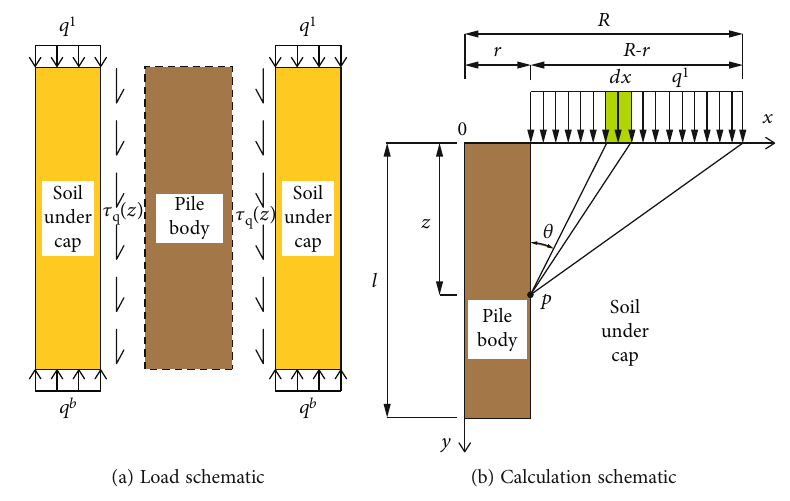
Figure 4: Calculation schematic of soil load q